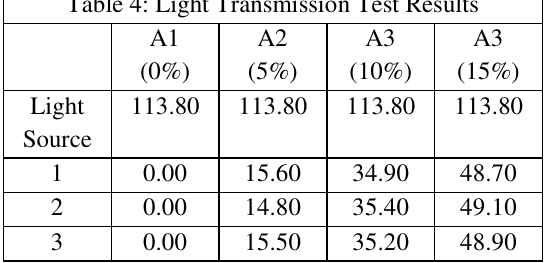
Table 4: Light Transmission Test